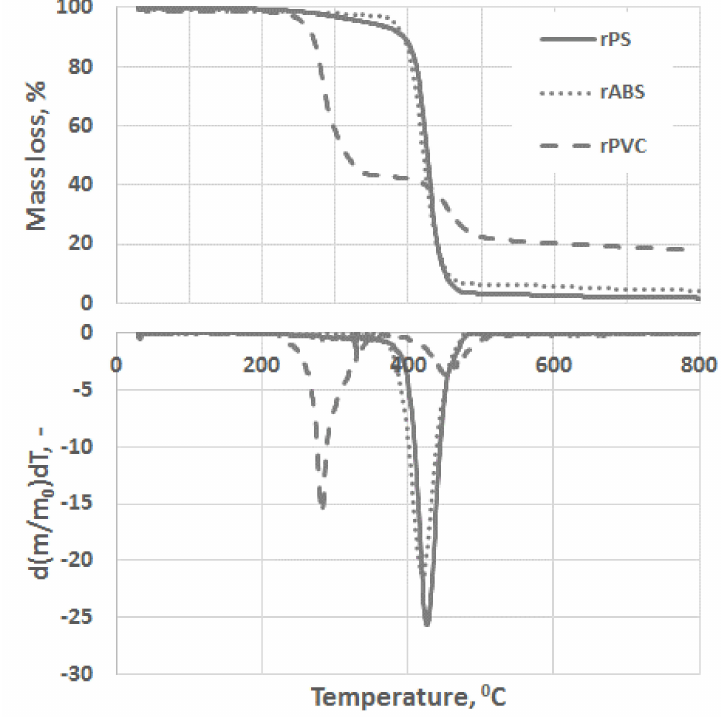
Figure 3. Thermogravimetric analysis (TGA) and differential thermogravimetry (DTG) curves of rPS, rABS and rPVC pyrolysis under a neutral